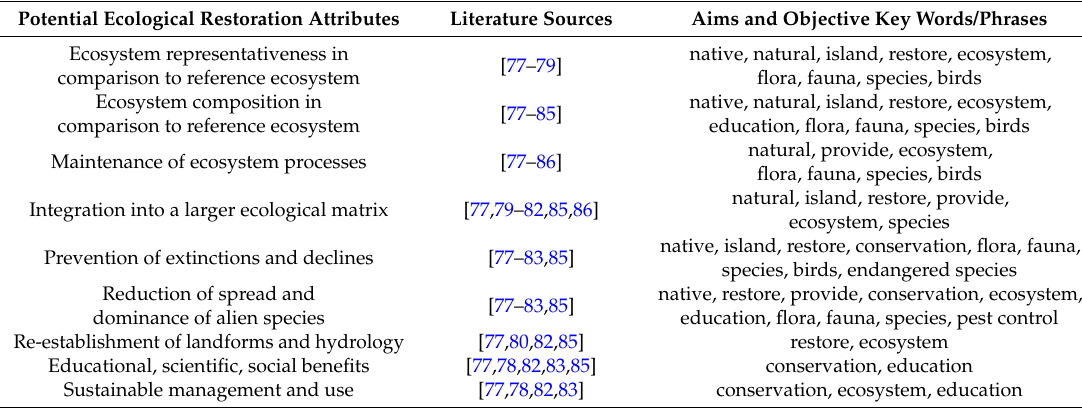
Table 3. Top 10 key words and top 2 multi-word expressions from community groups’ aims and objectives aligned with attributes of restored ecosystems.